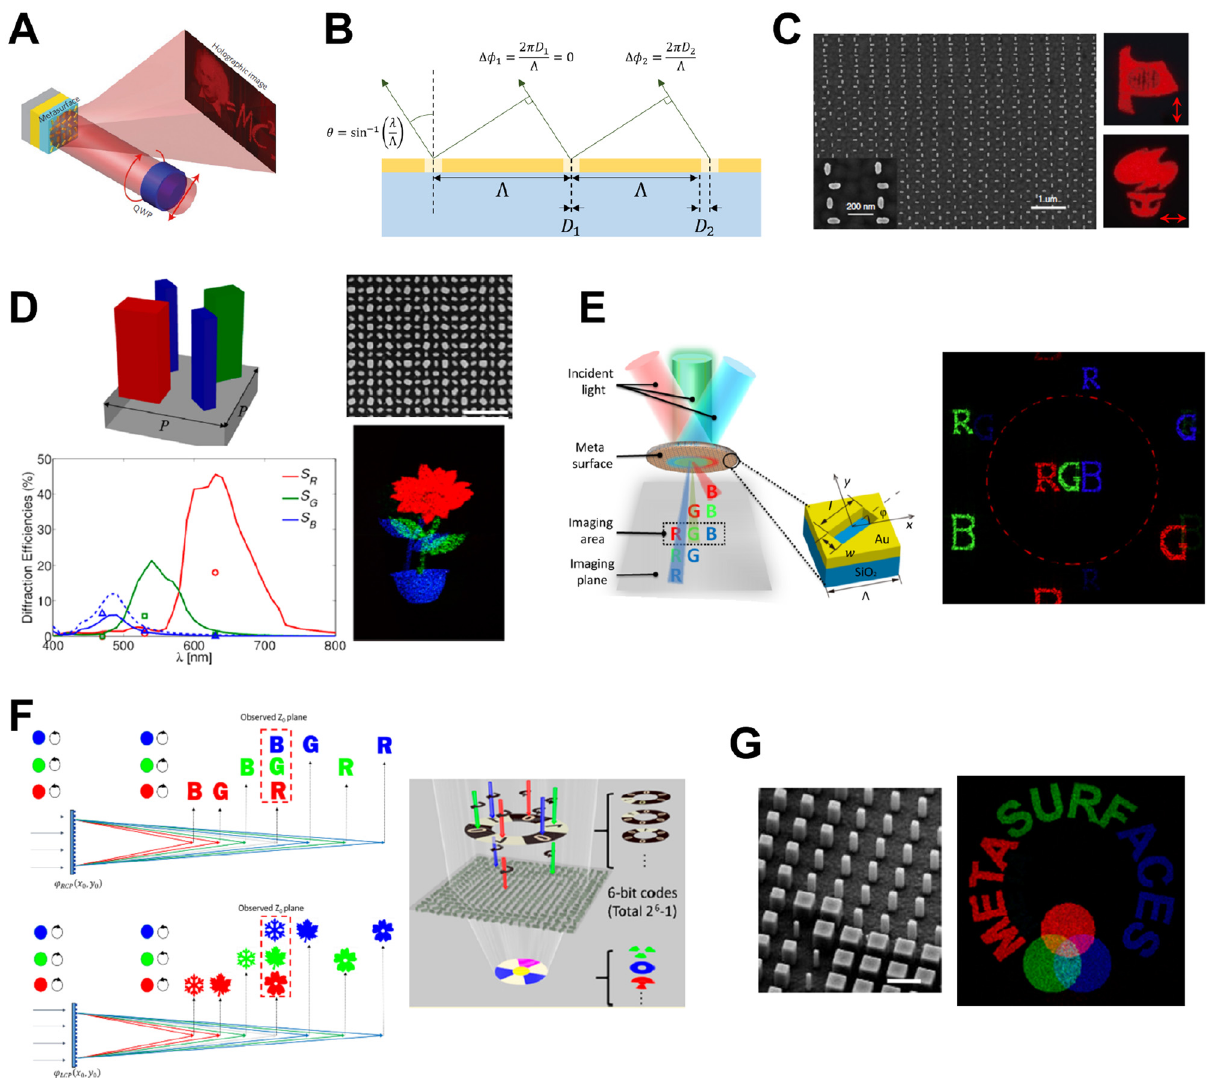
Figure 15: Meta-hologram. (A – C) Dispersion-less phase meta-hologram. (A) Meta-hologram with geometric phase. Adapted with permission fromRef.[151].Copyright2015,SpringerNature.(B)Conceptualexplanationofdetourphase.(C)Polarizationmultiplexedmeta-hologramwith detour phase. Left panel shows fabricated sample. Scale bar, 1 μ m. Inset is zoomed-in view with scale bar of 200 nm. Right panels show captured holographic images. Adapted from Ref. [158]. Copyright 2018, The Authors. Distributed under a Creative Commons Attribution 4.0 International License (CC BY). (D – G) Full-color meta-hologram. (D) Meta-hologram with polyatomic unit cell structure. Top-left panel shows schematic of polyatomic unit cell. Top-right panel shows fabricated sample. Scale bar, 1 μ m. Bottom-left panel shows diffraction ef fi ciency of resonators for three primary colors. Bottom-right panel shows captured colorful image. Adapted with permission from Ref. [150]. Copyright 2016, American Chemical Society. (E) In-plane image-multiplexed meta-hologram. Left panel shows working principle. Right panel shows simulated result. Since red dotted line corresponds to light line of free space, only center image can be propagated to the far- fi eld region. Adapted from Ref. [168]. Copyright 2016, The Authors, some rights reserved; exclusive licensee American Association for the Advancement of Science. Distributed under a Creative Commons Attribution-NonCommercial 4.0 International License (CC BY-NC). (F) Out-of-plane image- multiplexed meta-hologram. Left panels show the working principle included in the supplementary information of [173]. Top-left panel shows images generated when incident light is left-circularly polarized. Bottom-left panel shows images generated when incident light is right- circularly polarized. Right panel shows schematic of proposed meta-hologram with six independent channels. Adapted with permission from Ref.[173].Copyright2018,AmericanChemicalSociety.(G)Meta-hologramwith desireddispersion.Left panelshowsfabricatedsample.Right panel shows simulated images. Adapted with permission from Ref. [176]. Copyright 2018, American Chemical